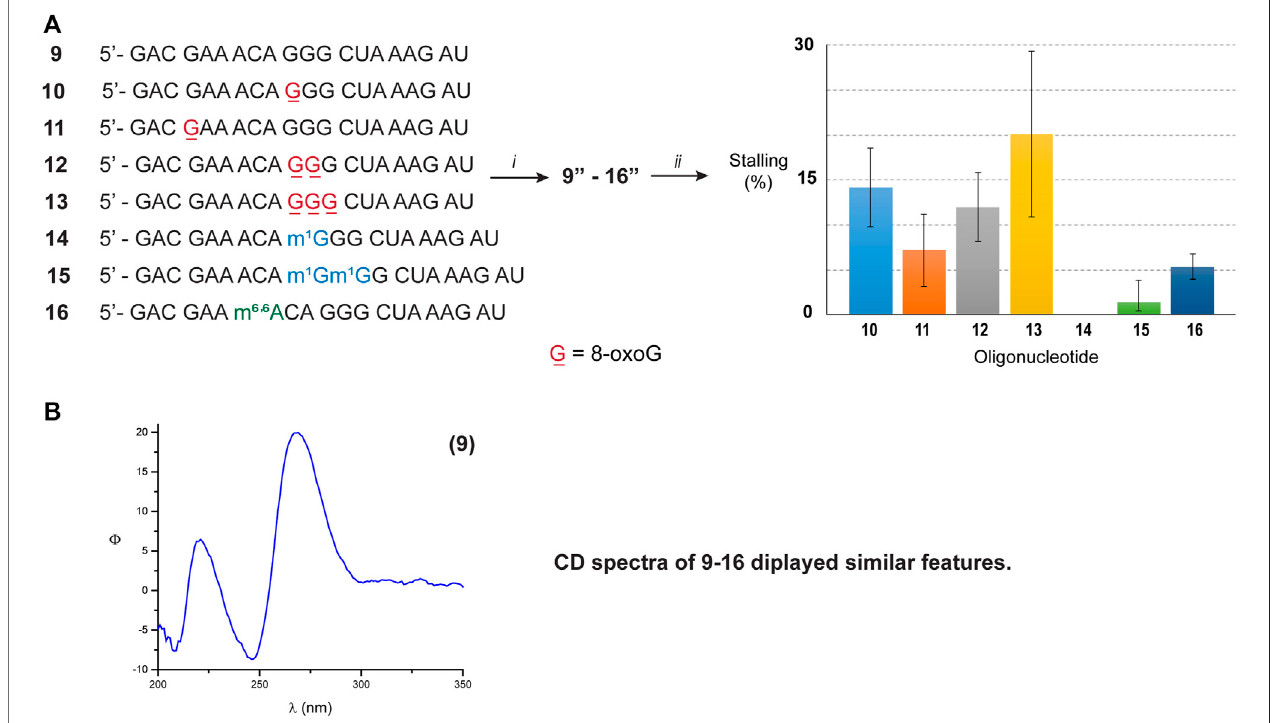
FIGURE 4 | Sequence of oligonucleotides 17 – 19 followed by preparation to the corresponding 17 ″ - 19 analogues: ( i ) T4-RNA ligase, bisphosphate 21 ; then T4- PNK, ATP; ( ii ) xrn-1, then dPAGE. The table inset shows the calculated yields for the observed fragments, corresponding to stalling at 8-oxoG.